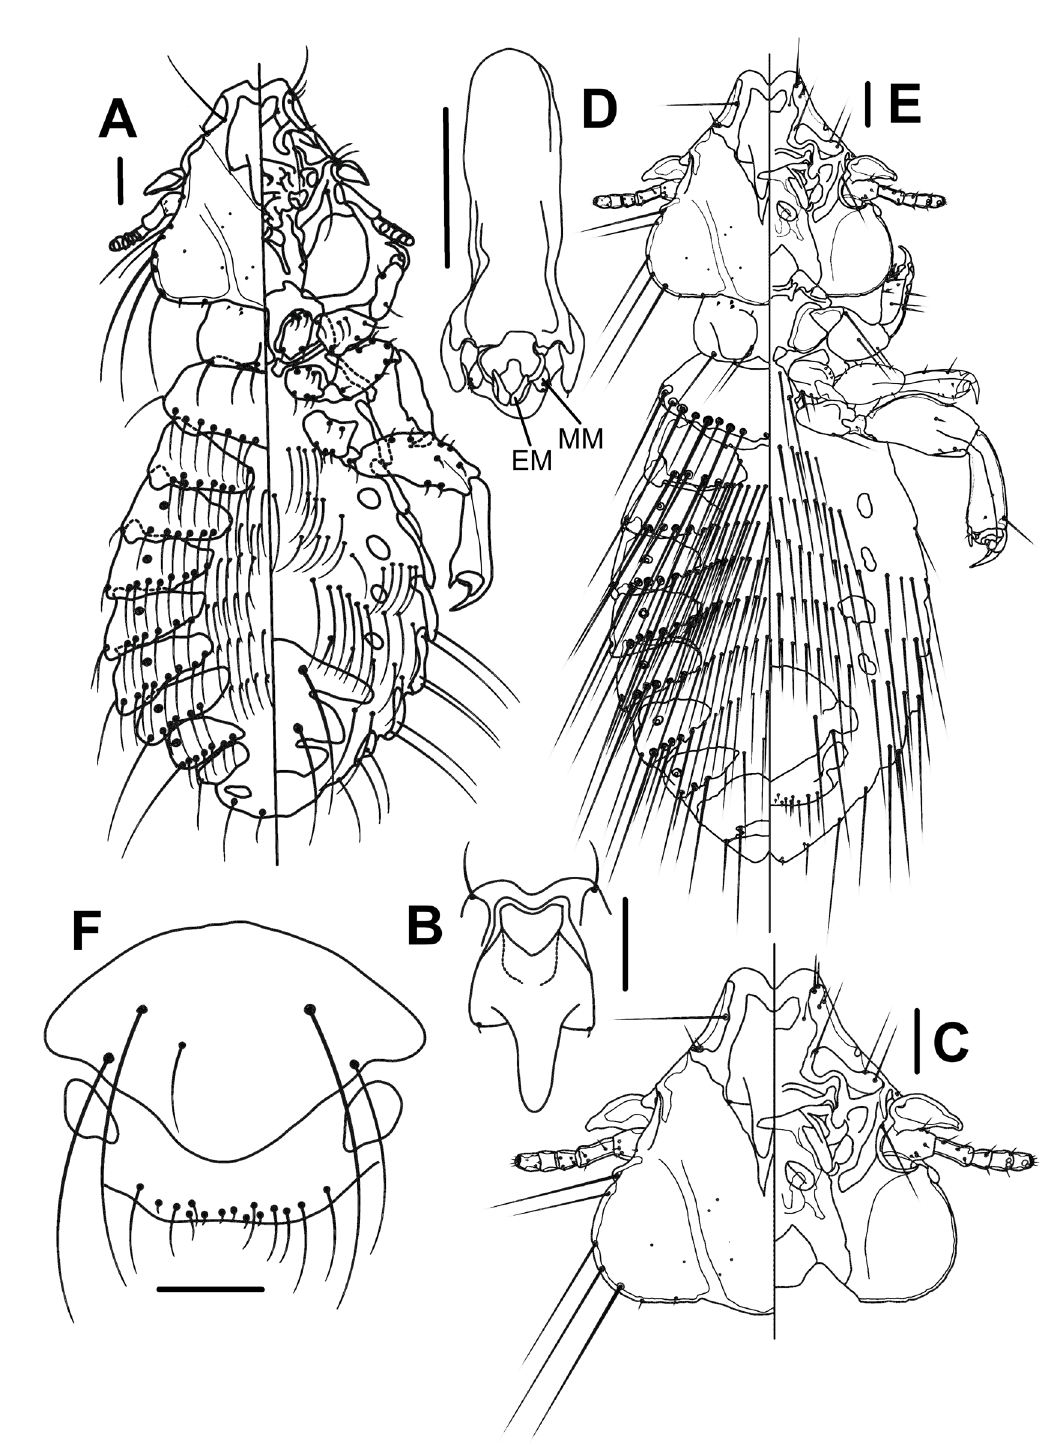
Fig. 6. Philopterus gustafssoni sp. nov. ex Regulus regulus (MMBC CZ-OS01): A . Male habitus, dorsal and ventral views. B . Male dorsal anterior plate (ADP), dorsal view. C . Female head, dorsal and ventral views. D . Male genitalia, ventral view. E . Female habitus, dorsal and ventral views. F . Female subgenital plate, vulval margin, and ventral terminalia, ventral view. Abbreviations: EM – endomere; MM – mesomere.Scale bars: 0.1